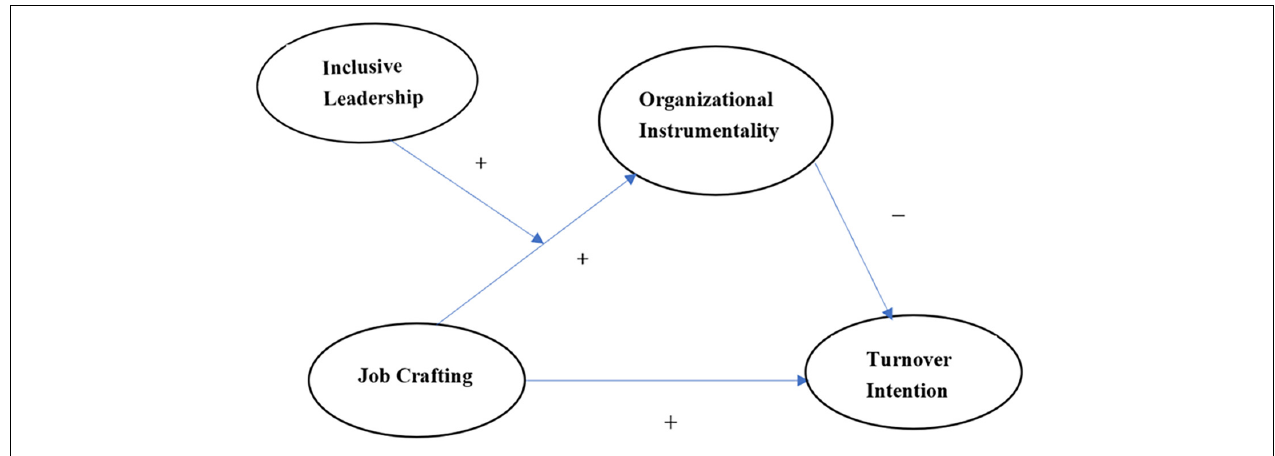
FIGURE 1 | The hypothesized